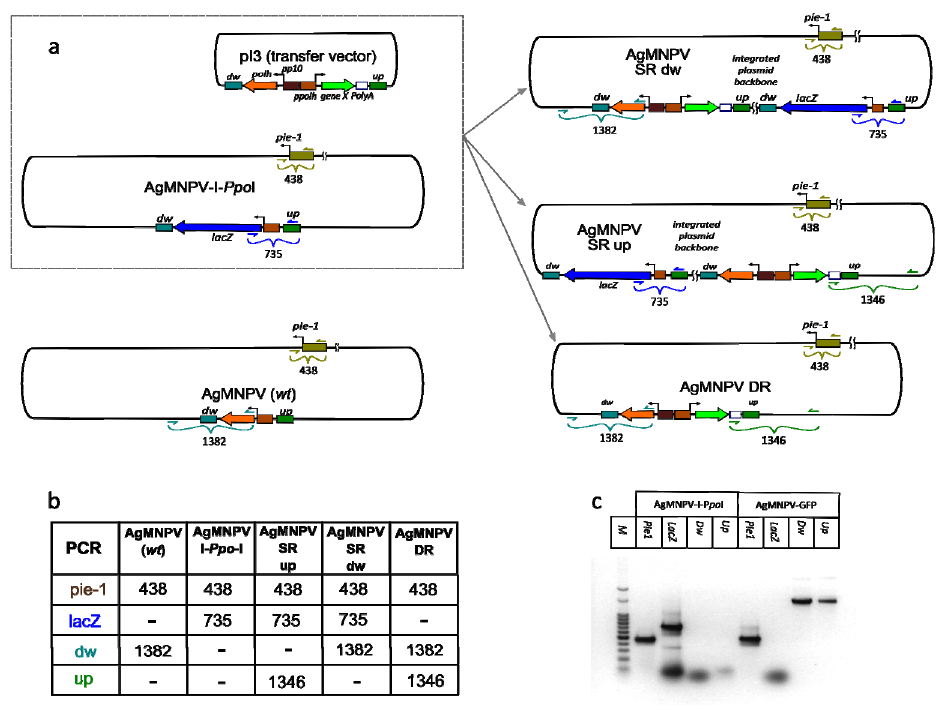
Figure 4. Characterization of cloned AgMNPV-GFP. ( a ) Schematic representation of plasmid (pI3-gene X) and viral DNA (AgMNPV-I- Ppo I) used in the study and possible viral genomic recombination products in plasmid-genome cotransfections. Genomes that could arise from uncut AgMNPV-I- Ppo I DNA are also included (SR: Single Recombinant; DR: Double Recombinant; dw and up : downstream and upstream polh ORF sequences where recombination could occur) Positions of PCR primers are indicated. A scheme of a wt AgMNPV is also included in order to clarify the origin of the putative PCR products that are shown in the table. ( b ) Table presenting the sizes of expected PCR amplicons in each possible genomic product (primers are those listed in Table 2); ( c ) Agarose gel electrophoretic patterns of PCR products using cloned AgMNPV-GFP (DR) and AgMNPV-I -Ppo I DNAs as